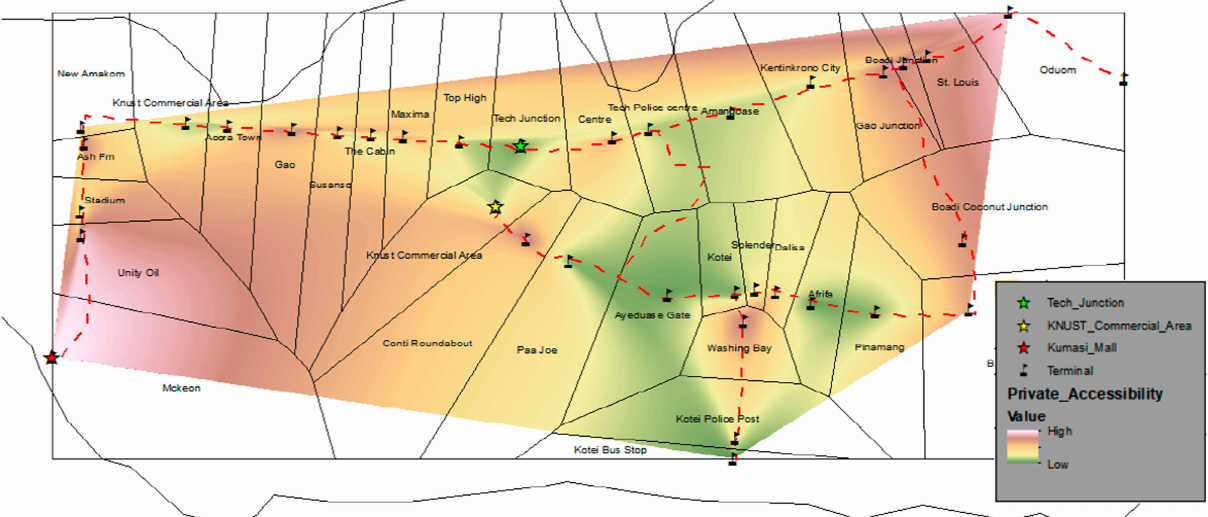
Figure 3: Accessibility level to commercial centre by private cars transport with green as low accessibility, pale yellow as average accessibility and brown as high accessibility.